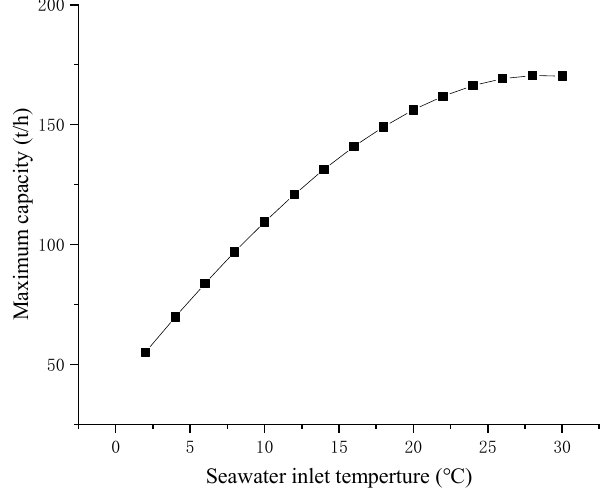
Figure 15. Effect of the LNG flow rate on the seawater outlet temperature.